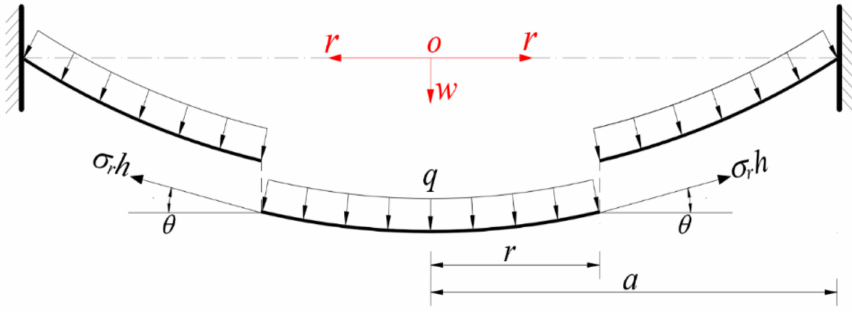
Figure 2. Free body diagram of the deflected circular membrane with radius 0 ≤ r ≤ a